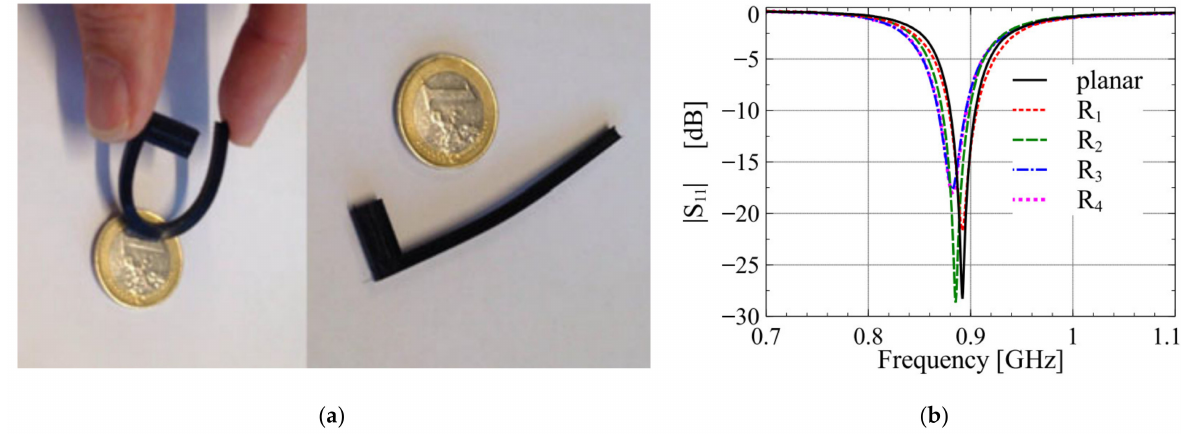
Figure 2. ( a ) NinjaFlex 3-D printed sample in bent and relaxed state. ( b ) Measured impedance matching for different radii of curvature. Reprinted with permission from Ref. [29]. Copyright 2017 IEEE.